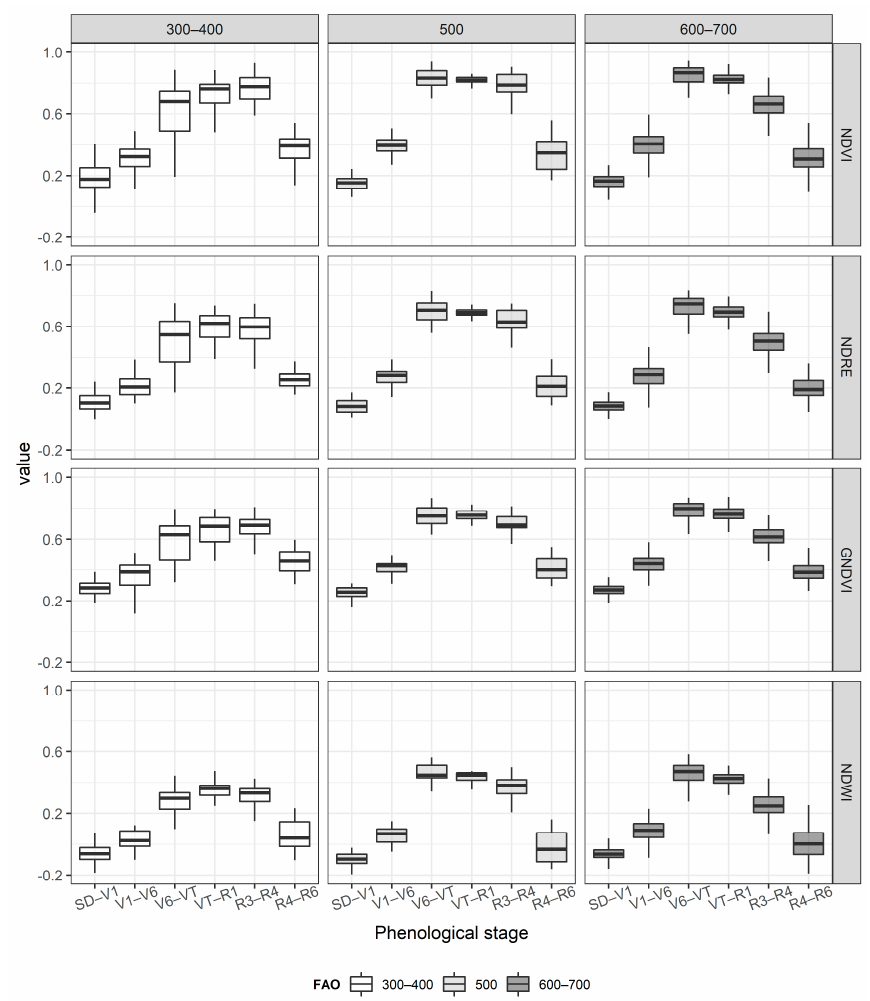
Figure 2. Distribution of average VIs (NDVI, NDRE, GNDVI, and NDWI) value by phenological phases for the three investigated earliness varieties (FAO classes reported). Stage abbreviation is as follows. SD: sowing; V1: emergence; V6: jointing-six leaf collars VT: tasselling; R1: Silk R4: dough; R6: maturity.